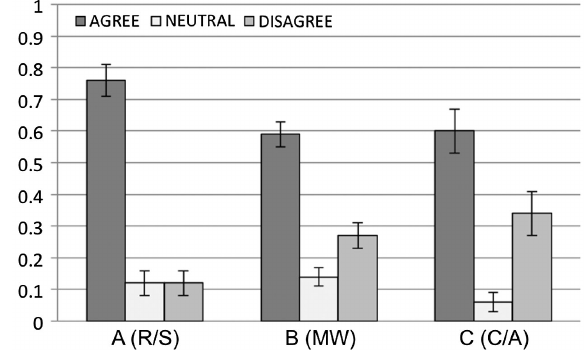
FIG. 4. Postinstruction student responses for courses A , B , and C . Students indicated whether they agreed, disagreed, or felt neutral about the statement: When not being observed, an electron in an atom still exists at a definite (but unknown) position at each moment in time. N ¼ 69 ( A ), 135 ( B ), and 47 ( C ); error bars represent the standard error on the proportion.